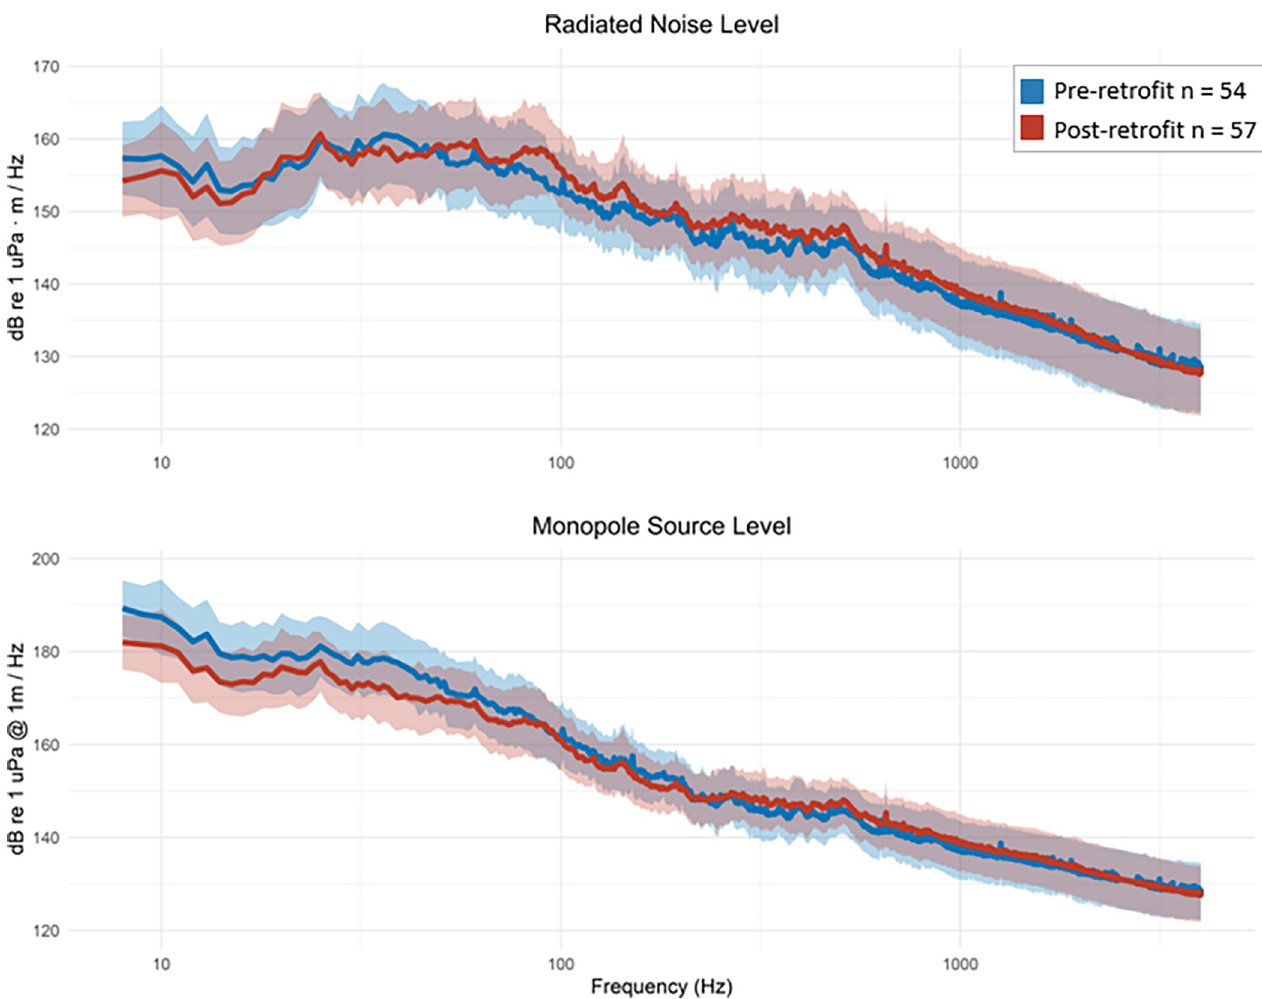
Fig 7. Estimated marginal means for noise levels pre- and post-retrofitting. Estimated marginal means (EMMs) ± standard deviation of radiated noise level (L RN ) and monopole source level (L S ) pre- and